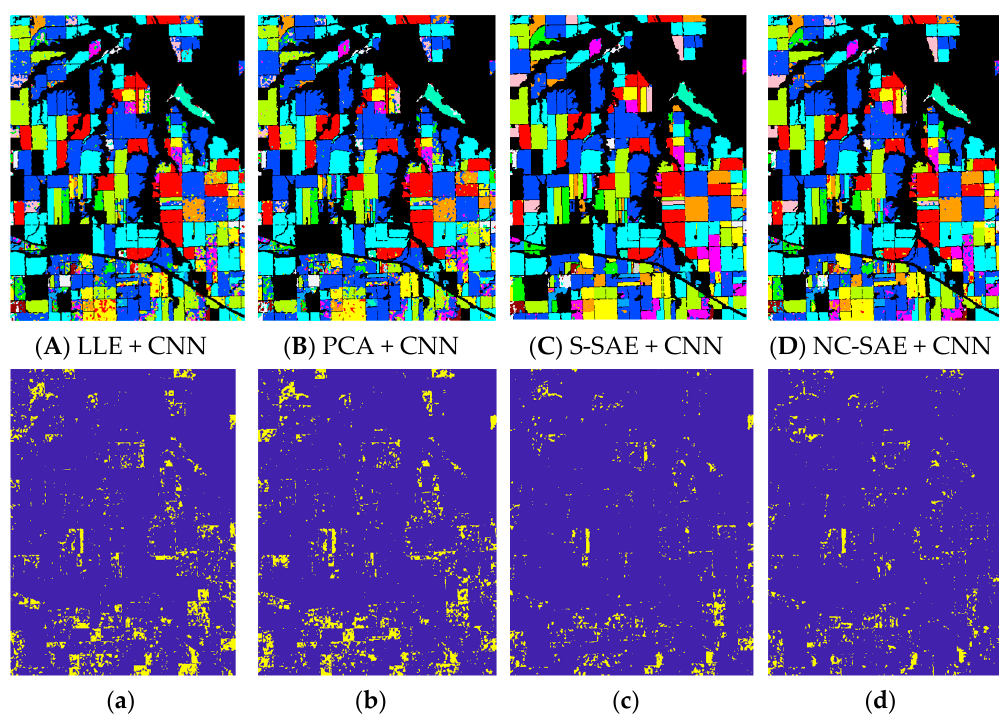
Figure 7. Classification results and error maps: ( A – D ) are the classification results maps of different dimension reduction methods which are ( A ) LLE + CNN, ( B ) PCA + CNN, ( C ) S-SAE + CNN, ( D ) NC- SAE + CNN. ( a – d ) are the error maps of ( A – D ).